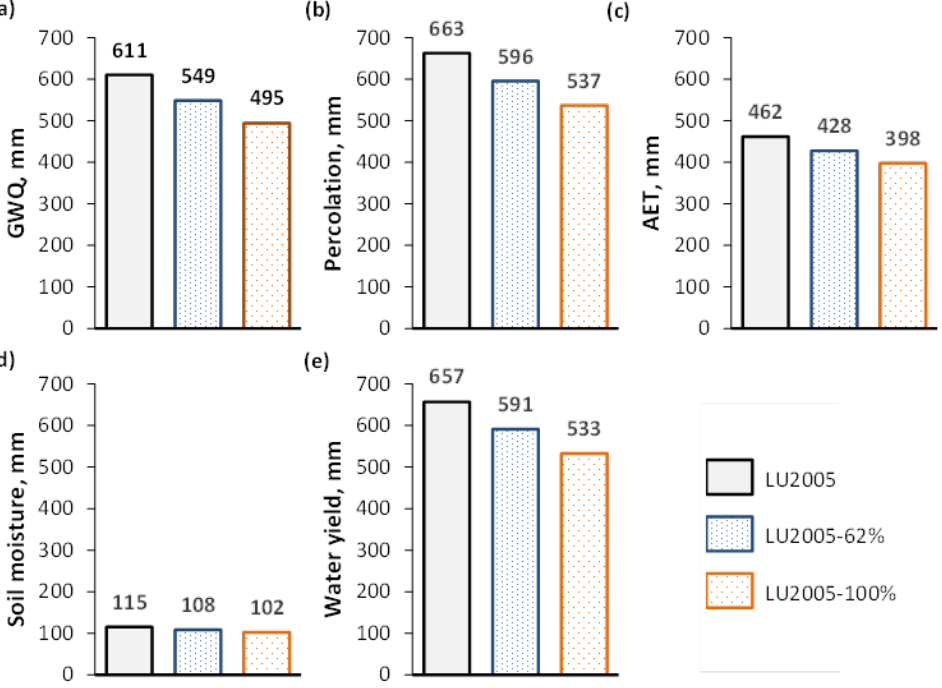
Figure 9. Water balance components: groundwater contribution to streamflow, GWQ ( a ), percola- tion ( b ), AET ( c ), soil moisture ( d ), and water yield ( e ) estimated for the observed land use pattern (LU2005) and under 62% (LU2005-62%) and 100% (LU2005-100%) afforestation scenarios in 2005, representing average conditions.